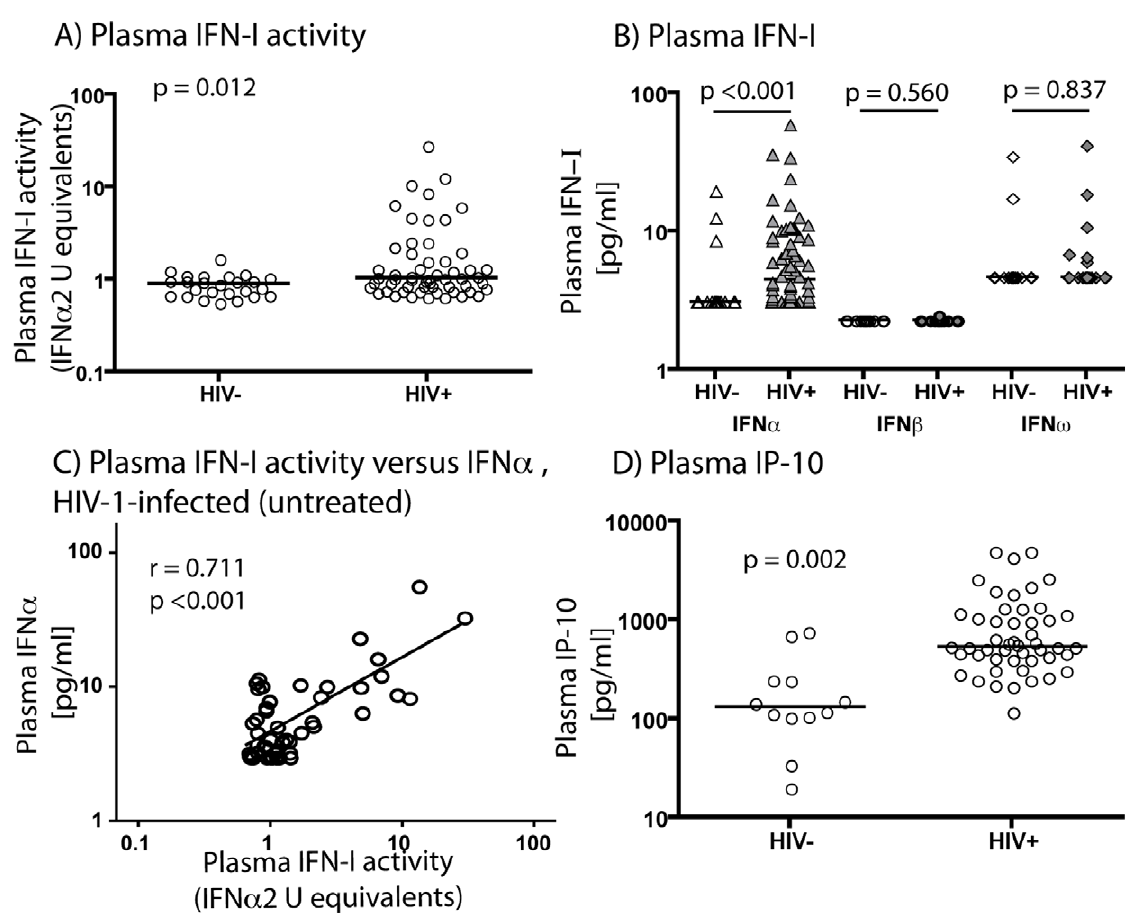
Figure 1. IFN a and its signature are increased in plasma of HIV-1-infected subjects not receiving ART. Plasma IFN-I bioactivity measured by the iLite TM bioassay was increased in plasma of HIV-1-infected subjects in comparison to uninfected subjects (median 1.04 IFN a 2 equivalent units for HIV-1-infected subjects, median 0.89 IFN a 2 equivalent units for uninfected subjects, p=0.012) (A). IFN a was increased in plasma of HIV-1-infected subjects in comparison to uninfected subjects (median 4.27 pg/ml for HIV-1-infected subjects, median 3.13 pg/ml for uninfected subjects, p , 0.001) (B). IFN b was not increased in plasma of HIV-1-infected subjects compared to uninfected subjects (median 2.34 pg/ml for HIV-1-infected subjects, median 2.34 pg/ml for uninfected subjects, p=0.560) (B). IFN v was not increased in plasma of HIV-1-infected subjects compared to uninfected subjects (median 4.69 pg/ml for HIV-1-infected subjects, median 4.69 pg/ml for uninfected subjects, p=0.837) (B). Plasma IFN a levels were strongly associated with plasma IFN-I bioactivity in HIV-1-infected subjects (r=0.711, p , 0.001) (C). Plasma IP-10 was increased in plasma of HIV-1-infected subjects in comparison to uninfected subjects (median 538.2 pg/ml for HIV-1-infected subjects, median 132.6 pg/ml for uninfected subjects, p=0.002) (D). Slight variations in sample sizes for different assays occur as results for some subjects were not